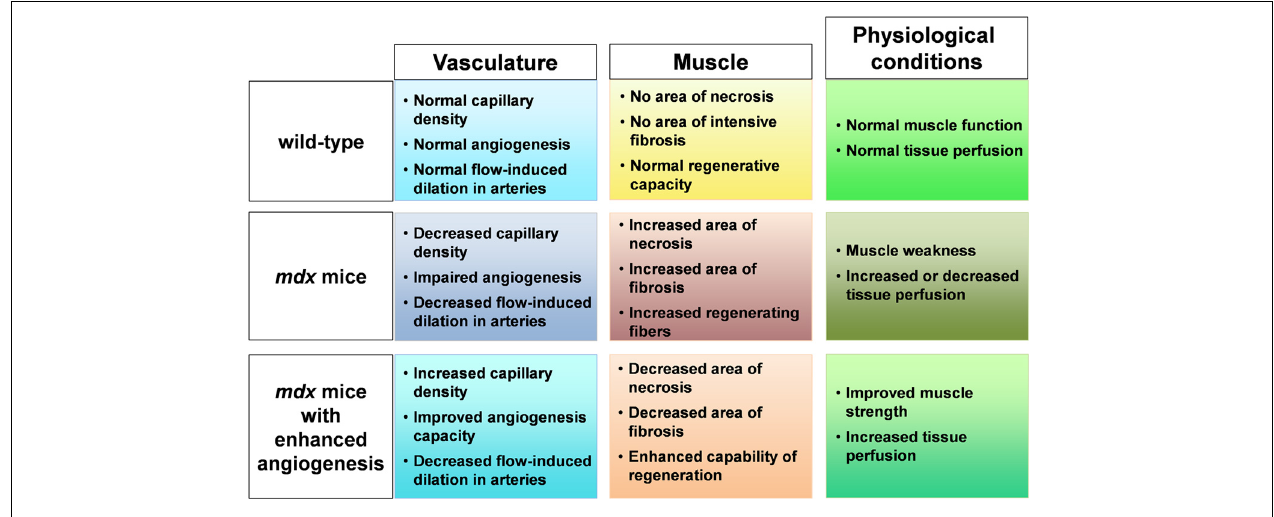
FIGURE 1 | Schematic figure of relationship between muscle, capillary, and physiological condition. In mdx mice, capillary density is decreased, angiogenesis is impaired with decreased flow induced dilation in arteries. When angiogenesis is enhanced in mdx mice,